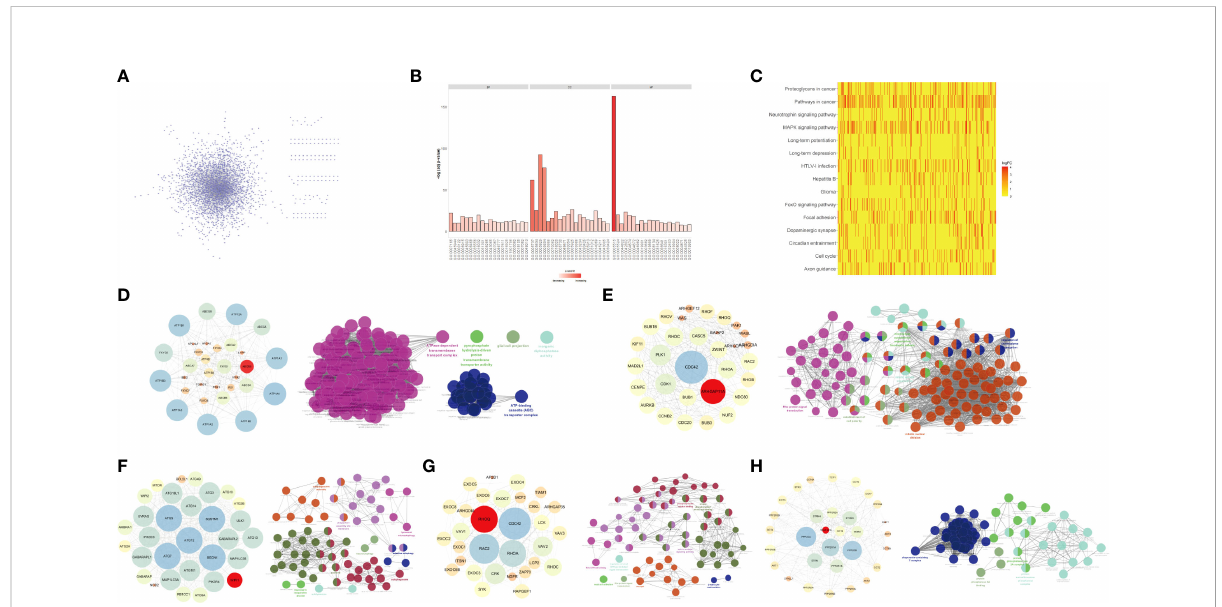
FIGURE 2 Key genes and their interaction networks. (A) The protein-protein interaction (PPI) network related to DEGs. (B) GO enrichment analysis of DEGs-related PPI network. (C) KEGG enrichment analysis of the PPI network associated with DEGs. (D) ABCB8 gene subnet and its function. (E) ARHGAP11A gene subnet and its function. (F) WIPI1 gene subnet and its function. (G) RHOQ gene subnet and its function. (H) TRAF3IP3 gene subnet and its